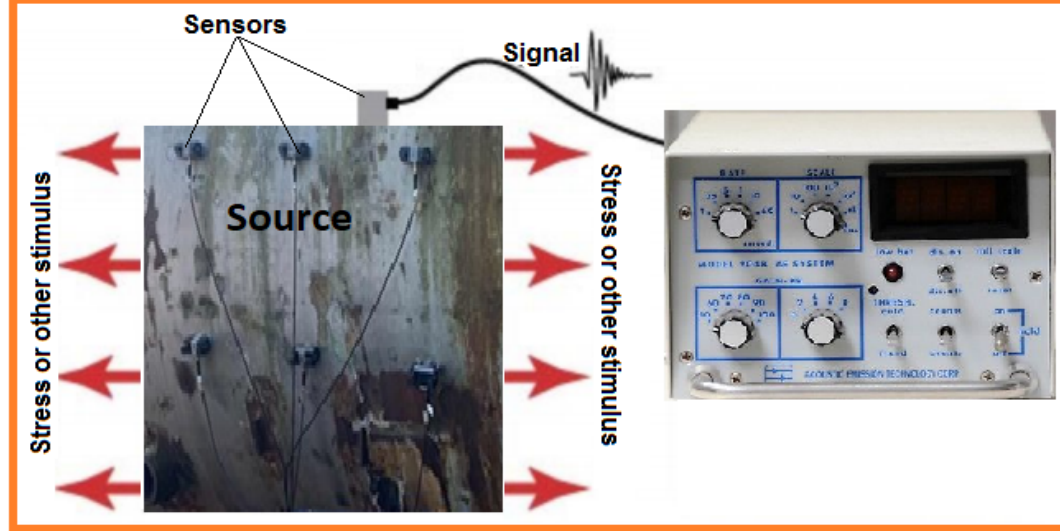
Figure 8. Schematic diagram of acoustic emission test (AE) for detection of material failure.